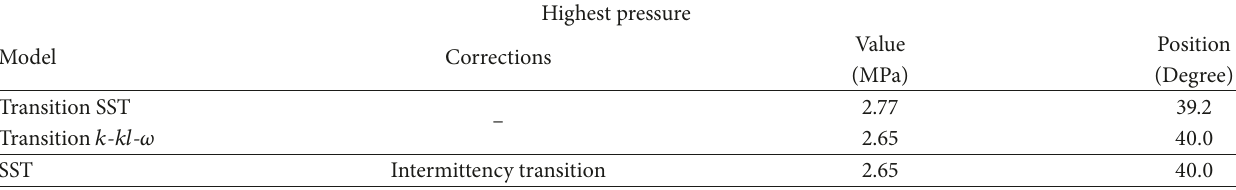
Table 8: Highest pressure of the transition turbulence models group.